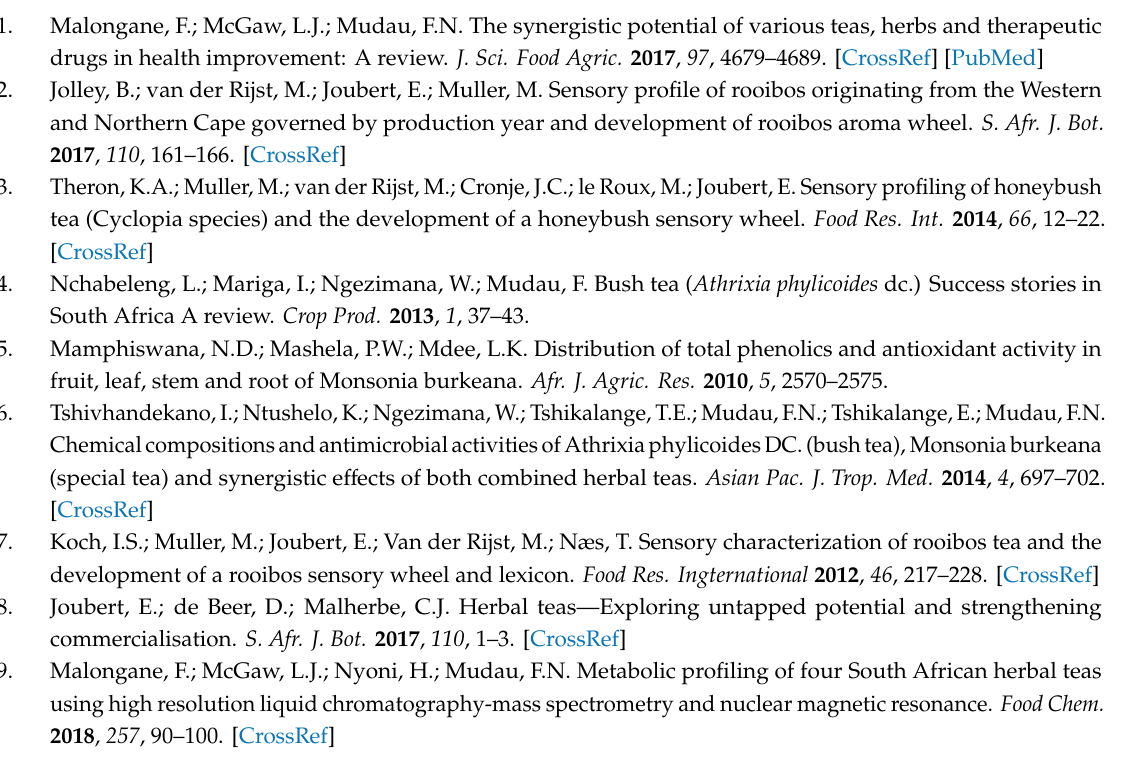
Table S1: Raw data from descriptive sensory evaluation, Table S2: Raw data from the data sourced from gas chromatography-mass spectrometer